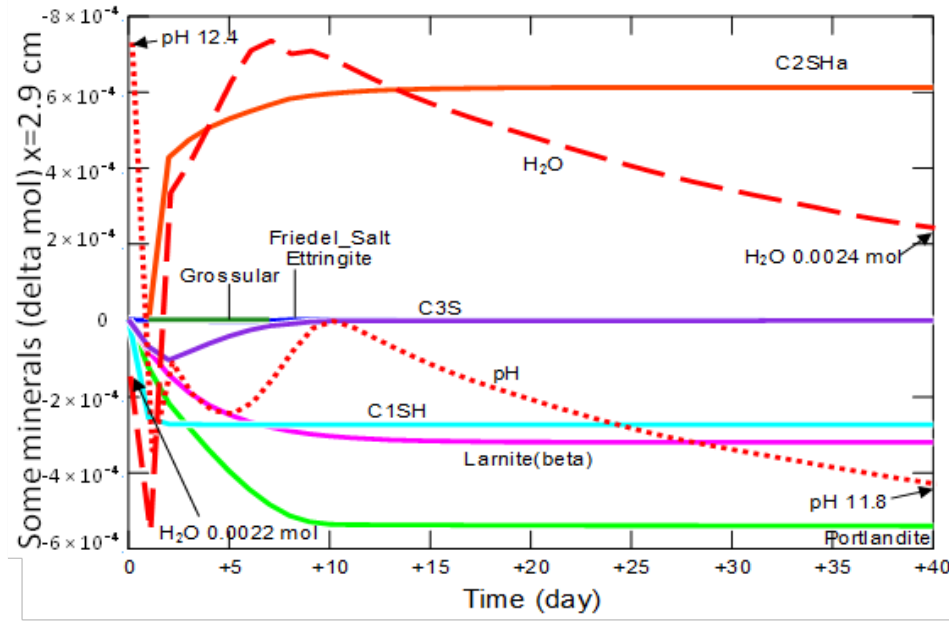
Figure 22. Changes in the amount of water, mineral phases and pH, in the cement matrix at a distance of 2.9 cm from the beginning of the model domain in conditions of ammonium chloride penetration.